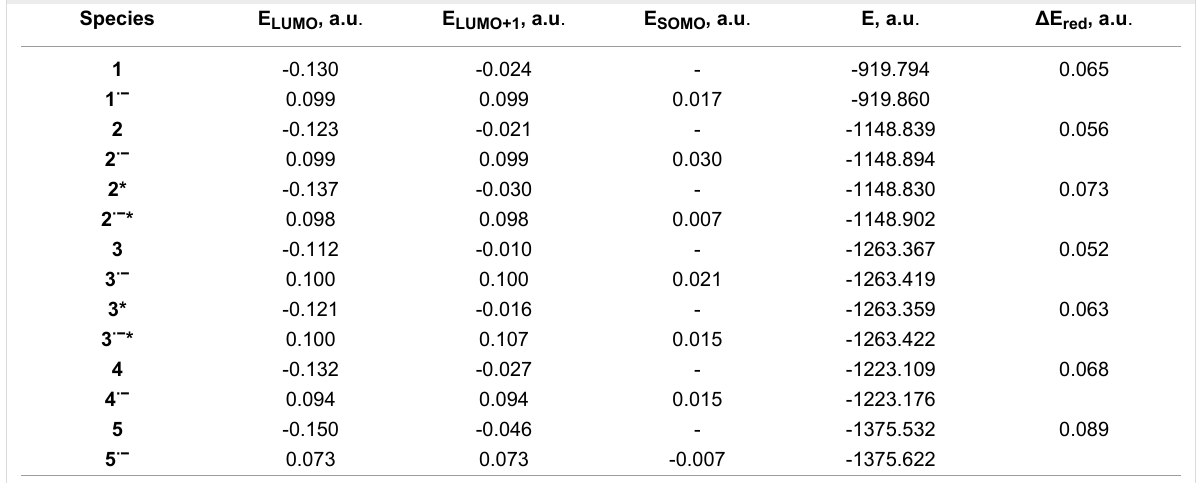
Table 2: Computed parameters for compounds 1 – 5 and for their reduced species 1 ·− – 5 ·− Species E LUMO , a.u . E LUMO+1 , a.u . E SOMO , a.u